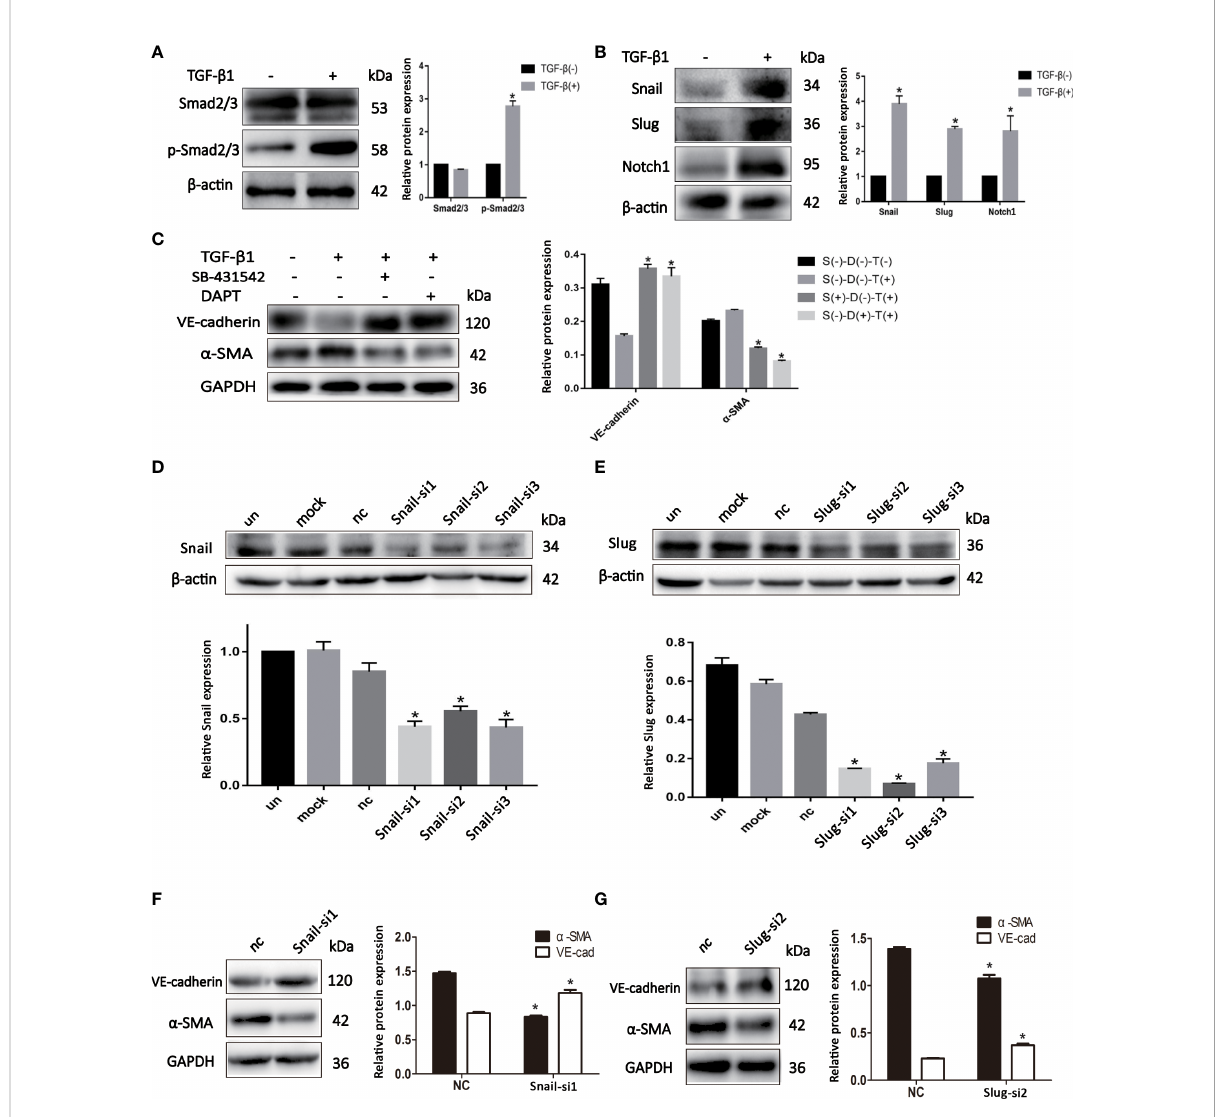
FIGURE 4 EndMT is regulated by TGF- b and Notch signaling pathways in BCSLCs. (A, B) The protein expression of TGF- b and Notch signaling pathways markers in differentiated-endothelial BCSLCs treated with or without TGF- b 1. (C) The protein expression of EndMT markers in differentiated- endothelial BCSLCs treated with SB-431542 or DAPT. * p < 0.05 versus S(-)-D(-)-T(-) group. (D, E) Knockdown of Snail and Slug were con fi rmed by western blot in differentiated-endothelial BCSLCs. *p < 0.05 versus un group. (F, G) The protein expression of EndMT markers in differentiated-endothelial BCSLCs with si-Snail and si-Slug. *p < 0.05 versus NC group. All data were representative of three independent experiments. Means ± SD were